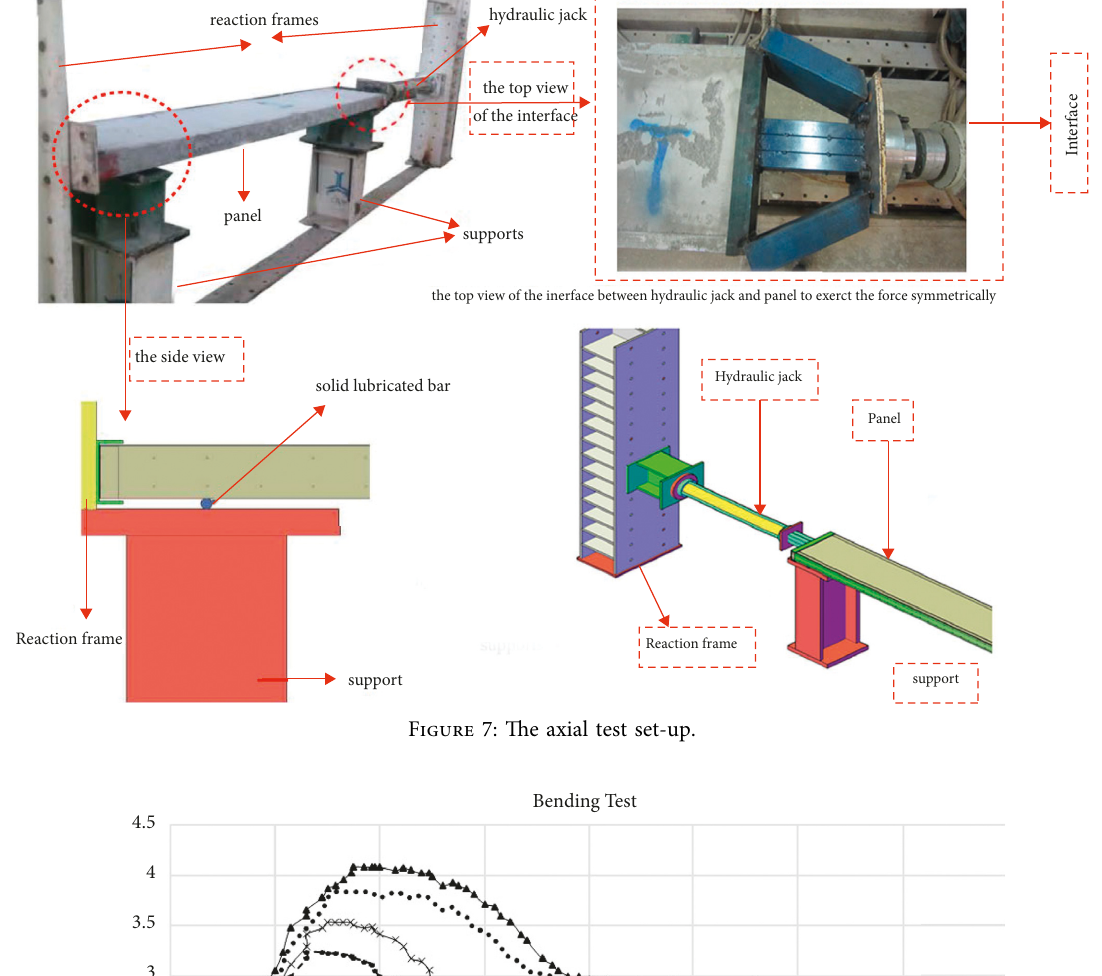
Figure 7: The axial test set-up.